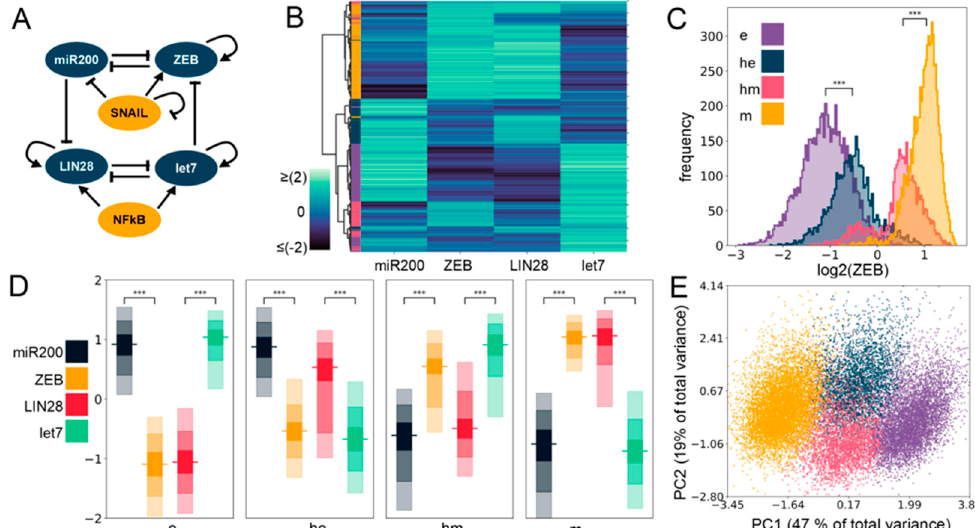
Figure 1. Four phenotypes enabled by the coupled Epithelial Mesenchymal Plasticity (EMP)–stemness circuit. ( A ) The core EMP–stemness circuit (base circuit). Arrows represent activating links and hammerheads represent inhibitory links. ( B ) Heatmap showing the steady-state expression of all solutions of a single replicate including the core EMP (ZEB, miR-200) and stemness (LIN28, let-7) nodes. ( C ) Expression histograms (all solutions from a single Random Circuit Perturbation (RACIPE) replicate. For n = 5, see Supplementary Table S2 in Section S2.1) showing ZEB levels in the four clusters—epithelial (e), hybrid epithelial (he), hybrid mesenchymal (hm), and mesenchymal (m). The colors of the labels shown in the heatmap are for e, he, hm, and m clusters displayed here. ( D ) Expression levels of EMP and the stemness genes in the four clusters. In each node, the horizontal line represents the median value, the darkest region represents the middle 30% (35th to 65th percentile) of the data, and the region next in lightness represents the next 40% (15th to 35th and 65th to 85th percentiles), while the lightest region represents the next 20% of the data (5th to 15th and 85th to 95th percentiles) ( E ) Principal Component Analysis (PCA) plot colored according to the K-means cluster assignment. (Principal Component 1 (PC1) = 0.48 × miR200 − 0.54 × ZEB − 0.21 × SNAIL − 0.49 × LIN28 + 0.44 × let7 + 0.057 × NF-kB; Principal Component 2 (PC2) = 0.27 × miR200 − 0.08 × ZEB − 0.66 × SNAIL + 0.14 × LIN28 − 0.49 × let7 − 0.47 × NF-kB). For ( C , D ): Significance bars added to show statistically significant differences (Mann–Whitney U test). Legend for the p -values: *** p < 0.0001; for effect sizes, refer to Table S7 in Supplementary Section